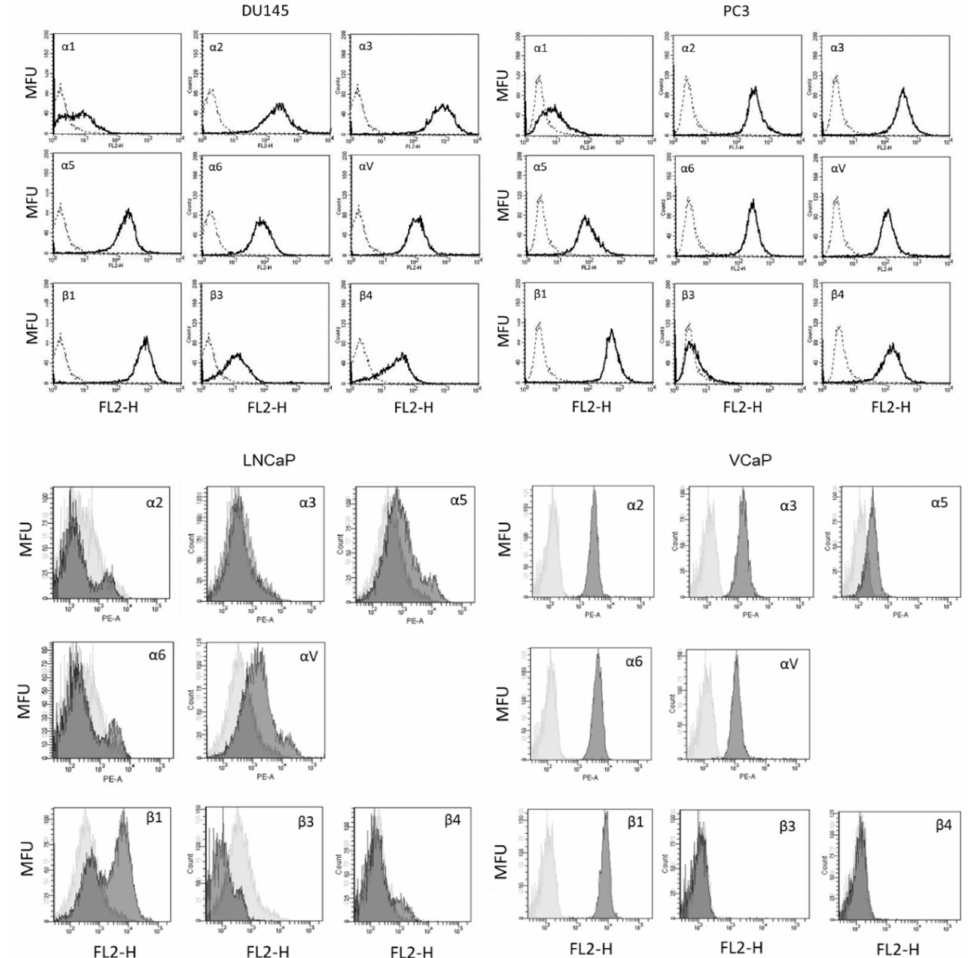
Figure 5. Surface expression of integrin α and β subtypes on DU145, PC3, LNCaP, and VCaP cells. Counts indicate cell number; fluorescence is expressed by mean fluorescence units (MFU). One representative of three separate experiments is shown. Solid line = specific fluorescence, dotted line = isotype